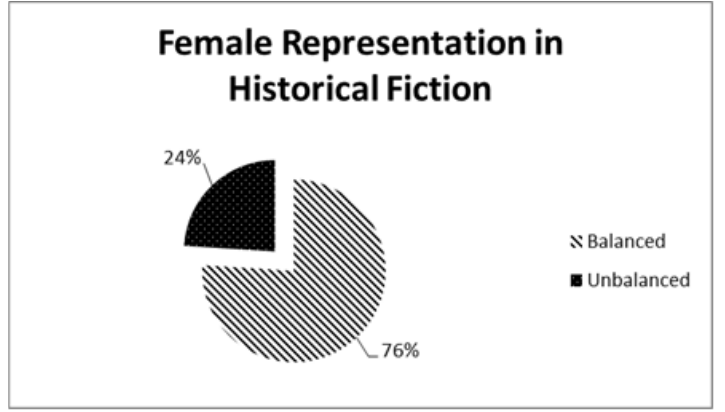
Female representation in novels classified as historical fiction. Female representation and empowerment was very strong, even within historical